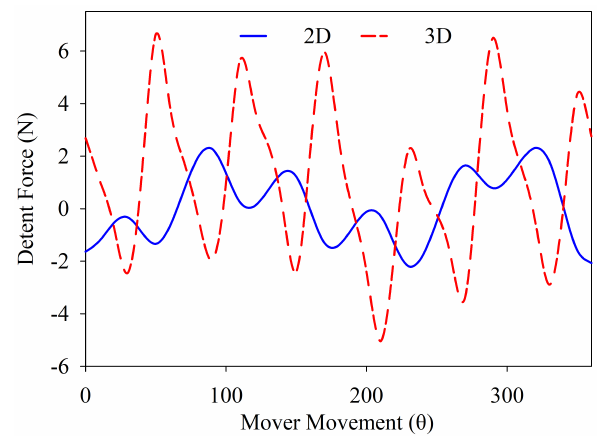
Figure 19. Detent force of 3D and 2D single-sided VFPMLM.